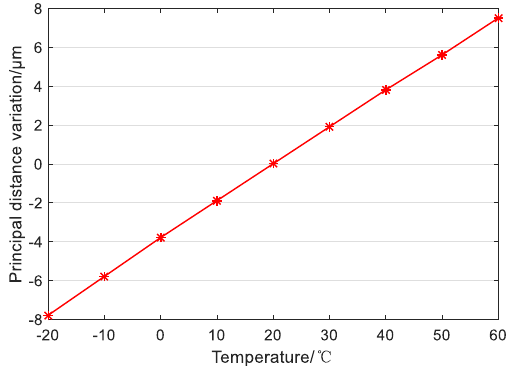
Figure 11. Variation of principal distance with temperature.